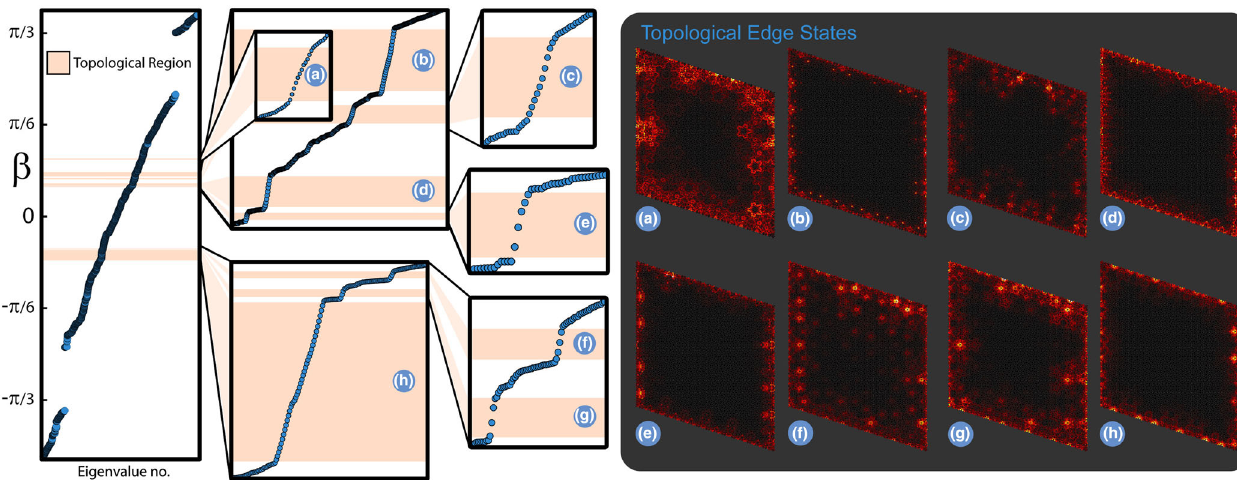
FIG. 8. The topological features occur for several levels of resolution of the energy spectrum. The left-hand panels show three generations of the fractal energy spectrum (with A 0 ¼ 3 and 15466 vertices), where the pink regions mark the topological band gaps. The right-hand panel shows the topological edge states associated with the second and third “ generations ” of the fractal spectrum of a finite topological quasicrystal, where (a) – (h) associate each edge state to each of the gaps shown in the left-hand